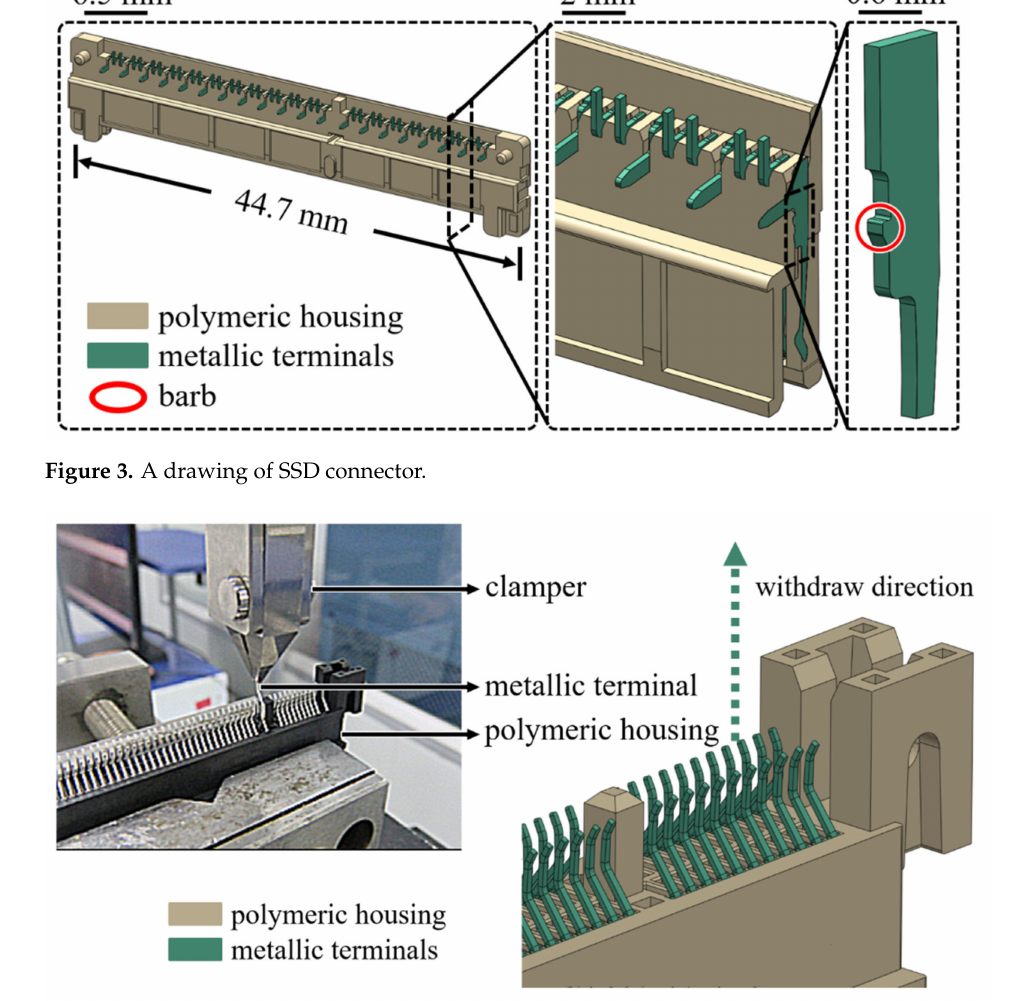
Figure 4. A schematic diagram of experimental set-up for the measurement of the retention